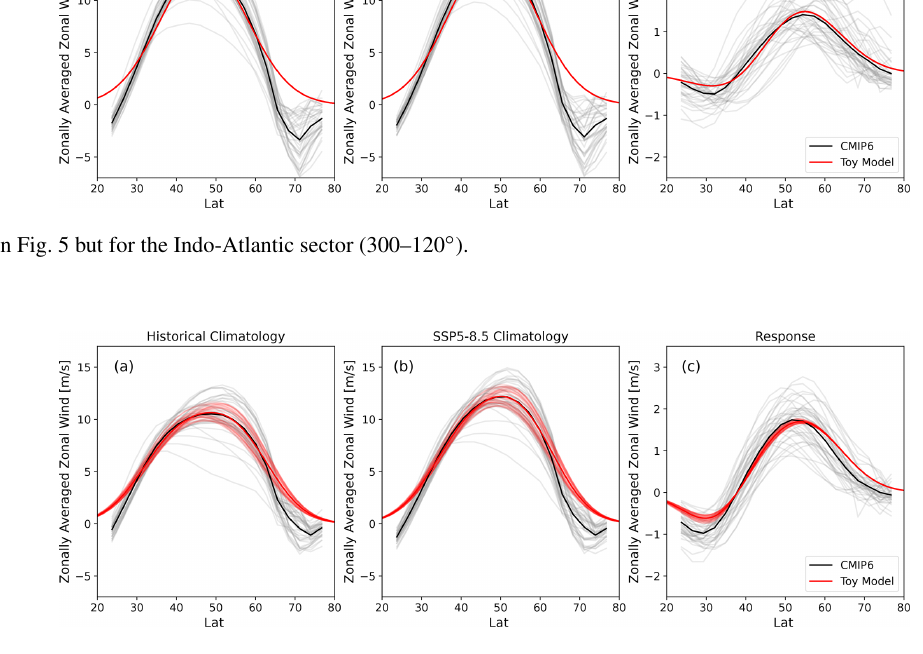
Figure B2. As in Fig. 5 but for the full hemispheric zonal